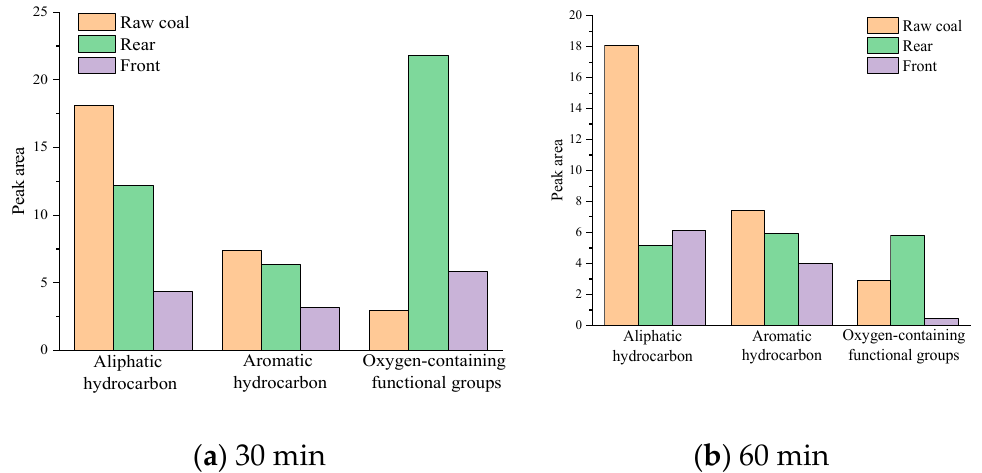
Figure 15. Variation of functional group content. ( a ) is the functional group content when the atomization time is 30 min; and ( b ) is the functional group content when the atomization time is 60 min.